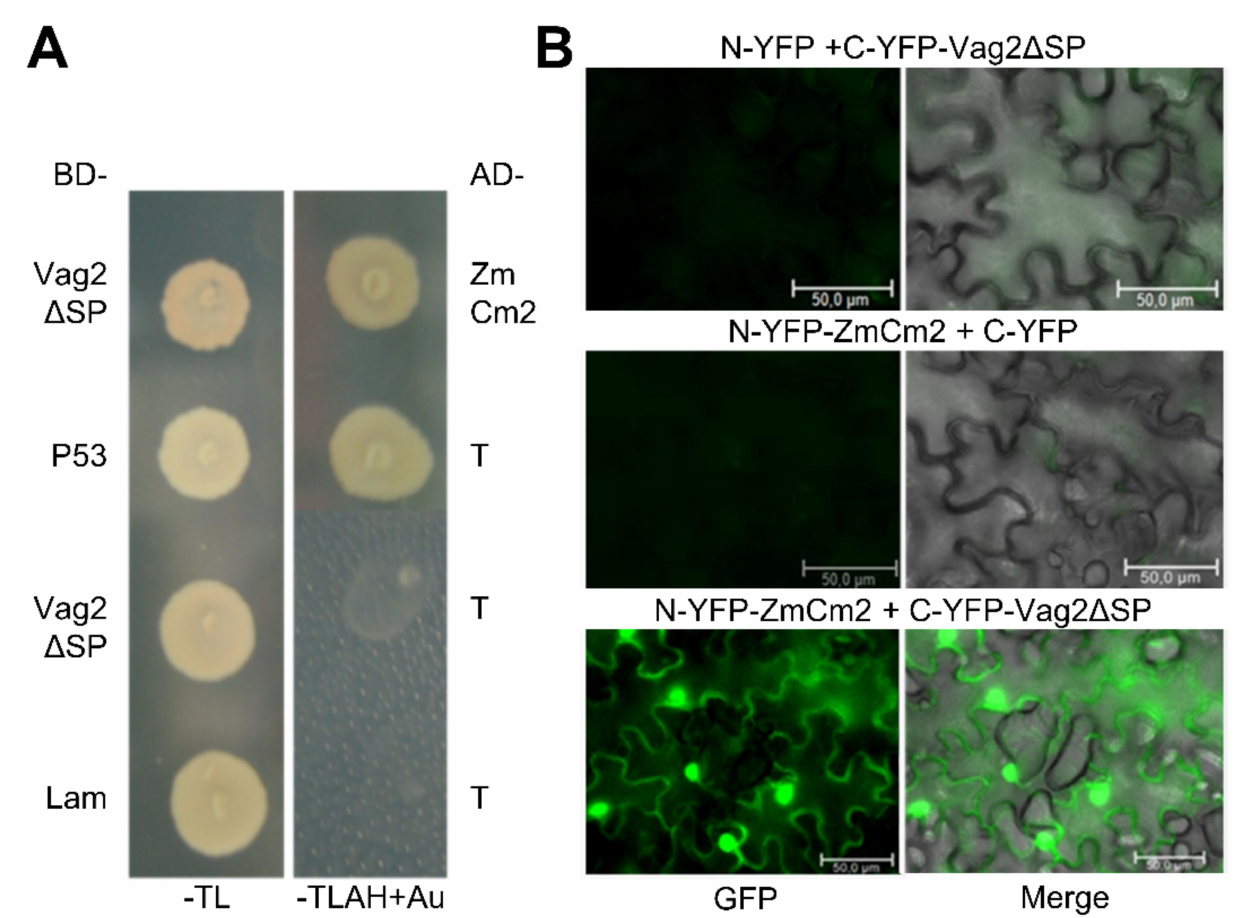
Figure 5. Vag2 interacts with ZmCM2. ( A ) Vag2 lacking its signal peptide was cloned in fusion with the GAL4 binding domain (BD-Vag2 ∆ SP) and introduced into the Y2HGold strain. One of the retrieved plasmids containing maize chorismate mutase-derived sequences in fusion to the GAL4 activation domain (AD-ZmCM2) was introduced into Y187. Both strains were mated, and diploids were selected on SD minimal media lacking tryptophan and leucine (-TL). Reconstitution of the GAL4 transcription factor by the interaction of Vag2 ∆ SP with ZmCM2 was verified by checking the expression of the GAL4-promoter controlled genes ADE2 and HIS3 as well as a gene allowing resistance to the drug aureobasidine A on SD medium lacking tryptophan, leucine, adenine and histidine, and containing aureobasidine A (-TLAH + Au). As a positive control, strains expressing tumor suppressor p53 (AD-P53) and the strong interaction partner SV40 T-antigen (BD-T), were used. As negative controls, strains were expressing Vag2 (BD-Vag2 ∆ SP) or Lamin (AD-Lam) and T-antigen (BD-T). ( B ) Bimolecular fluorescence complementation confirms in-planta interaction between Vag2 and ZmCM2. The N-terminal part of YFP was expressed alone (N-YFP) or as a fusion with ZmCM2 (N-YFP-ZmCM2), whereas the C-terminal part of YFP was expressed alone (C-YFP) or as a fusion with Vag2 lacking its signal peptide (C-YFP-Vag2 ∆ SP) after infiltration of Nicotiana benthamiana leaves with Agrobacterium tumefaciens cells delivering the indicated constructs. At 3 days after infiltration, the leaves were analyzed by fluorescence microscopy. YFP fluorescence was only seen when both fusion proteins were co-expressed. Shown are representative cells under conditions enabling detection of GFP fluorescence ( left ), and a merge of the GFP fluorescence and brightfield pictures ( right ). Size bars: 50 µ